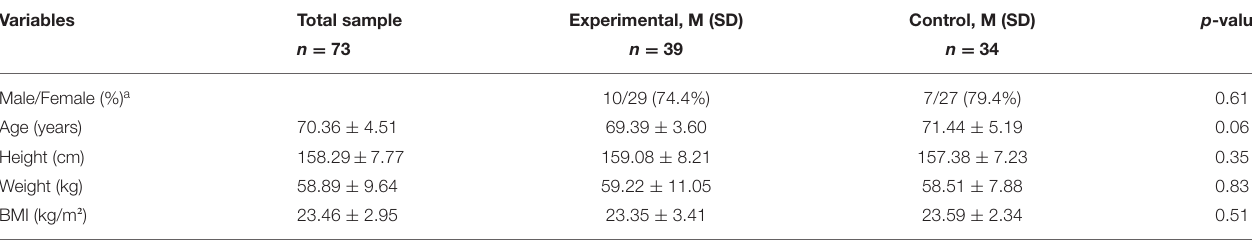
TABLE 1 | Demographic characteristics of participants.